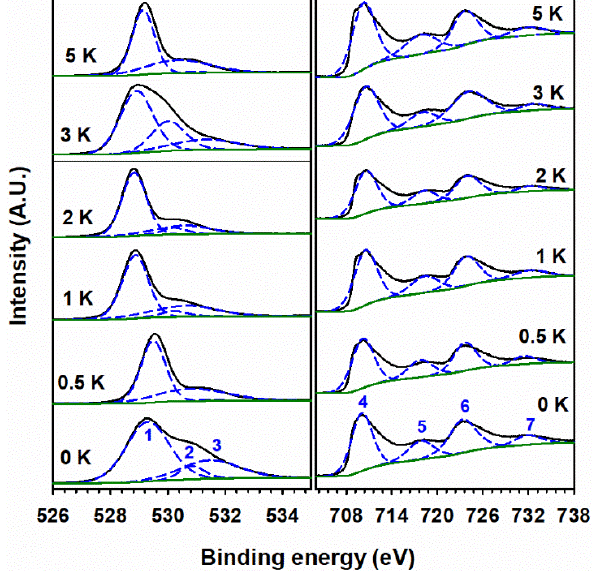
Figure 6. (Black trace) High-resolution XPS spectra of ( left panel ) O 1 s and ( right panel ) Fe(III) 2 p for 100 Fe: x K materials, calcined at 400 °C, with the atomic ratio of potassium ( x ) indicated in each panel. Dashed blue lines show the fitted peaks, numbered as follows: (1) O 1 s for lattice oxides, (2) lattice hydroxyl, (3) surface hydroxyl, (4) Fe(III) 2 p 3/2 , (5) Fe 2 p 3/2 satellite, (6) Fe(III) 2 p 1/2 , and (7) Fe(III) 2 p 1/2 satellite. Solid green lines show the fitted background.